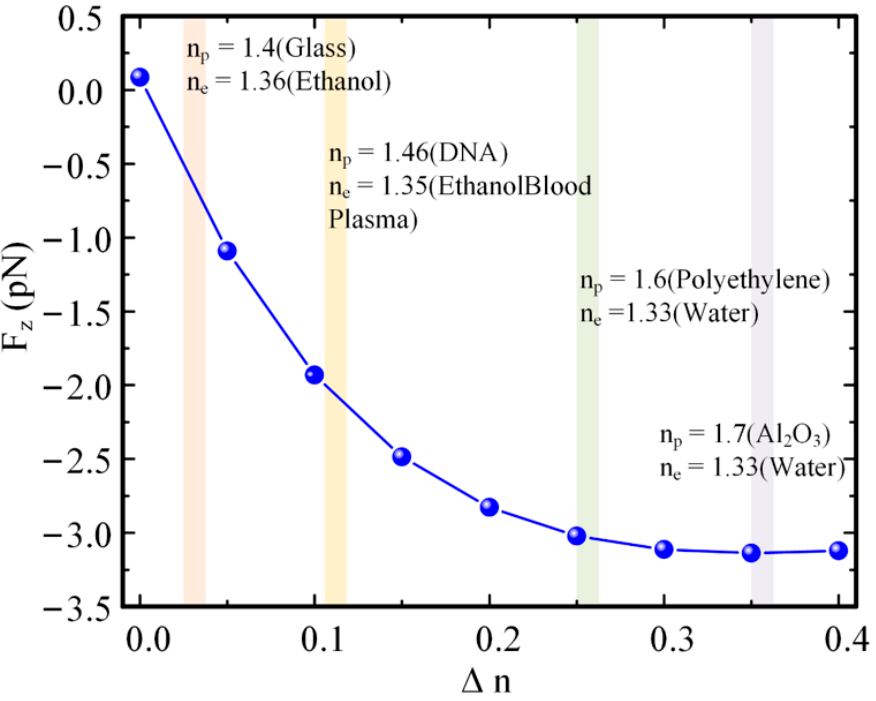
Figure 4. The optical forces on nanoparticles of different materials in different environment materials, ∆ n = n p − n e . n p and n e are the refractive indices of the nanoparticles and the trapped environment, respectively.